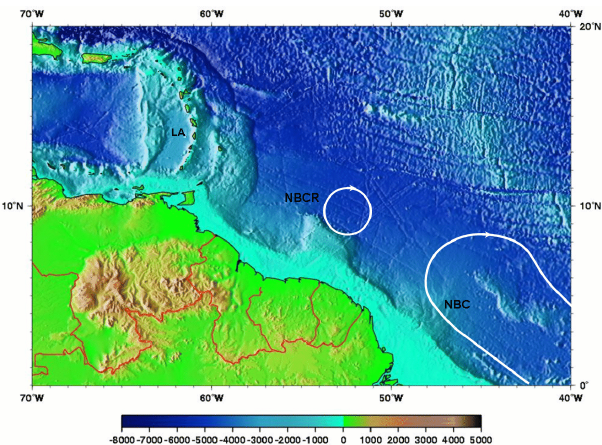
Figure 1. Region of study in the western Tropical Atlantic (70-40ºW and 0-20ºN) Fig. 1. Region of study in the western Tropical Atlantic (70–40 ◦ W showing topography in the vicinity of the Lesser Antilles (LA), North Brazil Current (NBC) and shedded anticyclonic ring (NBCR). and 0–20 ◦ N) showing topography in the vicinity of the Lesser An- tilles (LA), North Brazil Current (NBC) and shedded anticyclonic ring